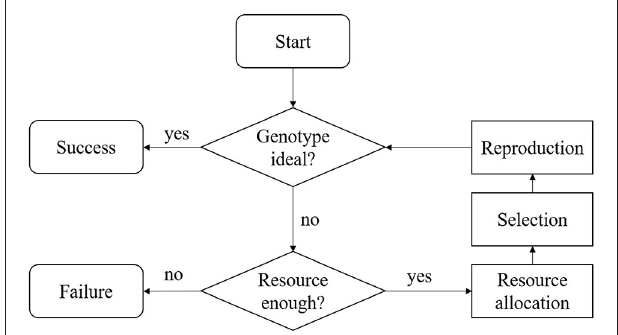
FIGURE 1 | Flowchart of the MATI